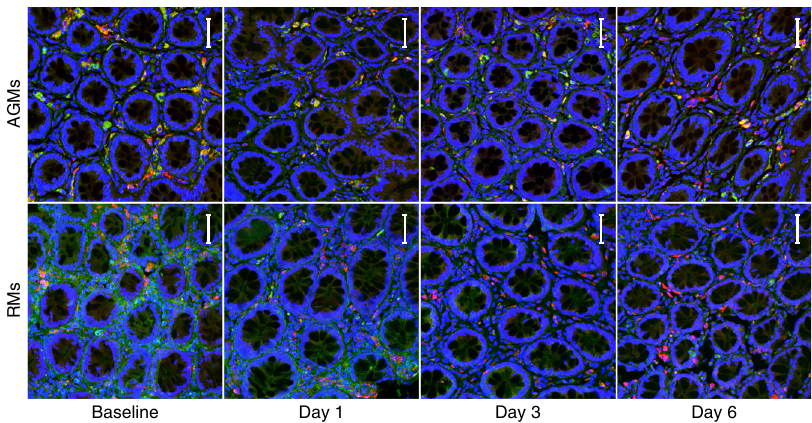
Fig. 6 Immuno fl uorescent staining for HAM56/FN in lamina propria. Rectum from AGMs (top) and RMs (bottom) was doubled stained for HAM56 (red) and FN (green), with a DAPI stain (blue) to visualize nuclei. Colocalization, if any, appears as yellow. From left to right, representative images are shown from 0 – 6 days post-infection. All images are at ×200 magni fi cation. Each image represents a maximum intensity projection form a z-stack of 11 – 28 images at 1.78 μ m per step, with a resolution of 0.321 μ m/pixel. The scale bar included in each image represents a length of 50 μ